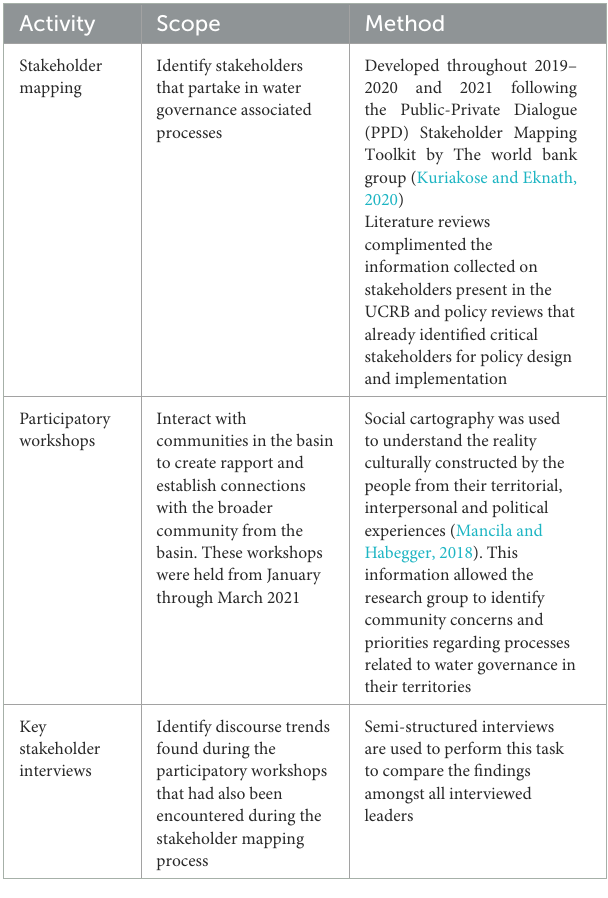
TABLE 1 Activities, scope and methods